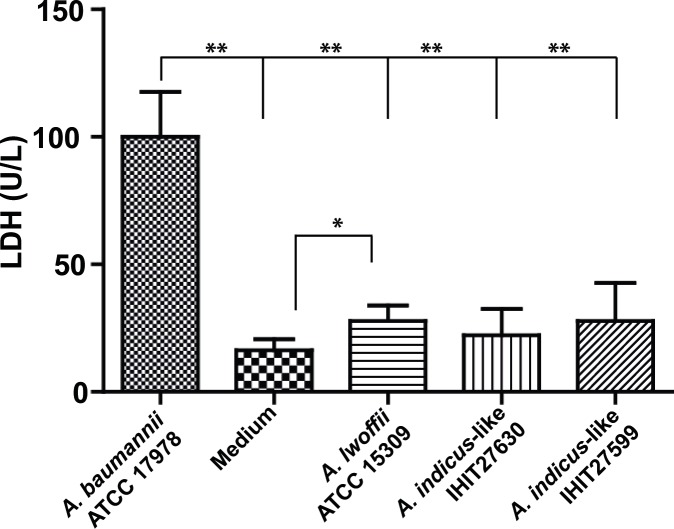
Acinetobacter spp. mediated cytotoxicity towards A549 human lung epithelial cells.Confluent A549 monolayers were infected for 20 h with an MOI of 100 with the indicated bacteria. Supernatants were harvested and LDH activities determined. Mean value for Triton X-100 (positive control) was 924.0 ± 93.7 U/L. Medium (DMEM) was used as a negative control. Shown are mean values ± standard deviations from n = 3–4 experiments. Asterisks indicate a significant difference between the control group (medium) and strains, respectively (* p<0.05; **p<0.001).